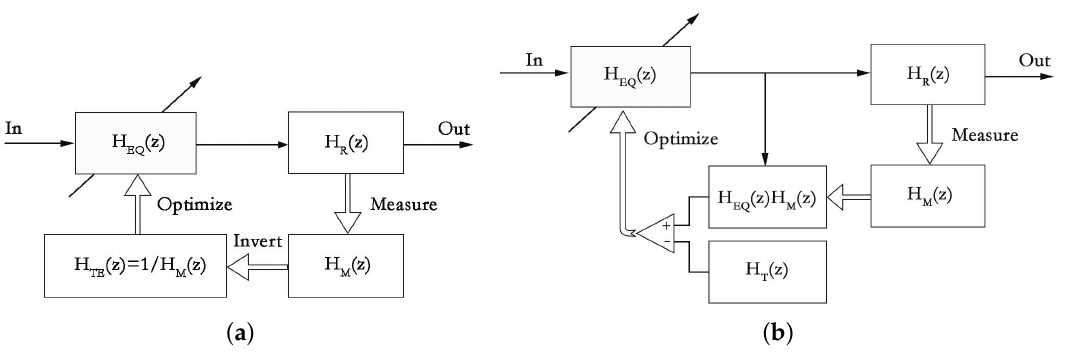
Figure 3. ( a ) Indirect and ( b ) direct equalizer design methods classification as reported in [55], where H EQ represents the equalization filter, H R is the reproduction channel, H M is the measured impulse response, and H T and H TE are the target